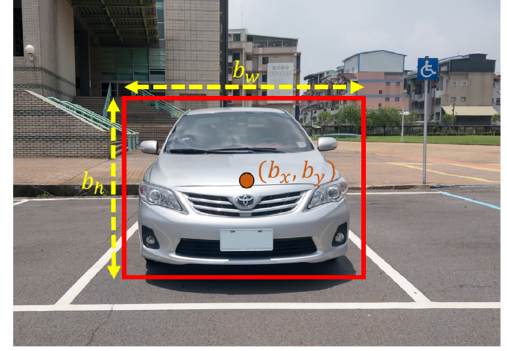
Figure 6. Bounding boxes drawn using YOLOv4-Tiny.